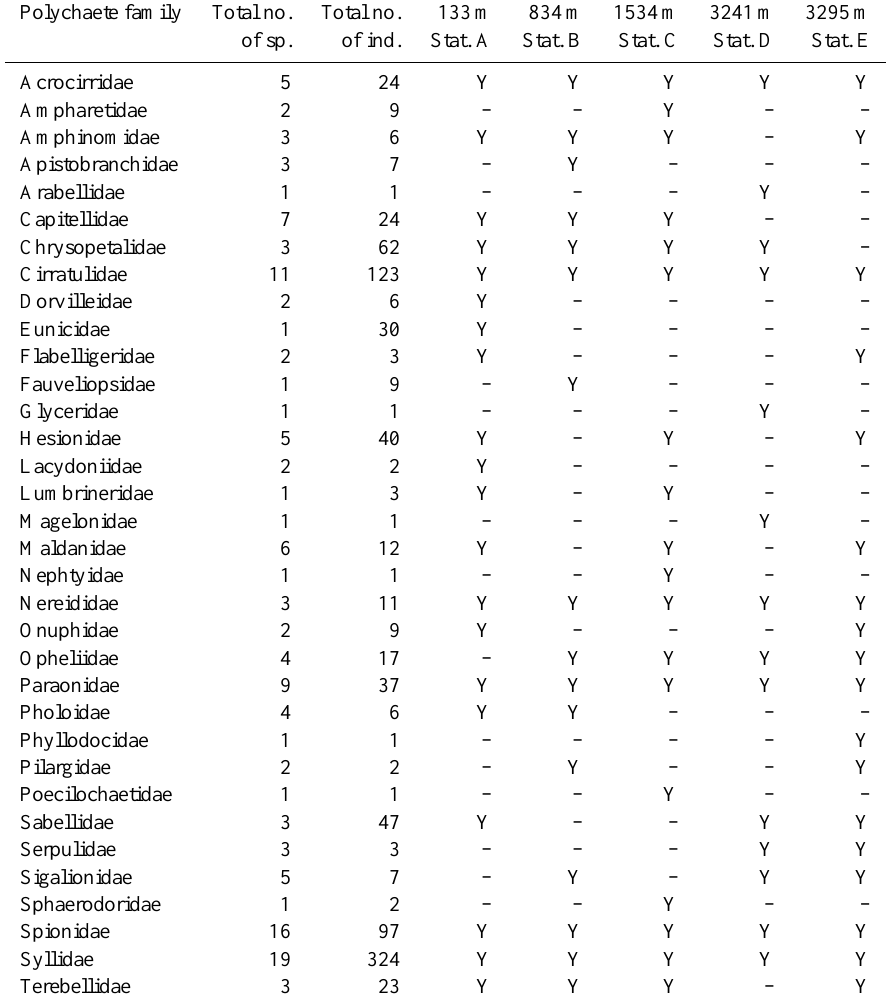
Table 3. Polychaete family analysis (total no. of species, total no. of individuals, presence (Y)/absence (–), according to depth). Polychaete family Total no. Total no. of sp. of ind. Stat. A